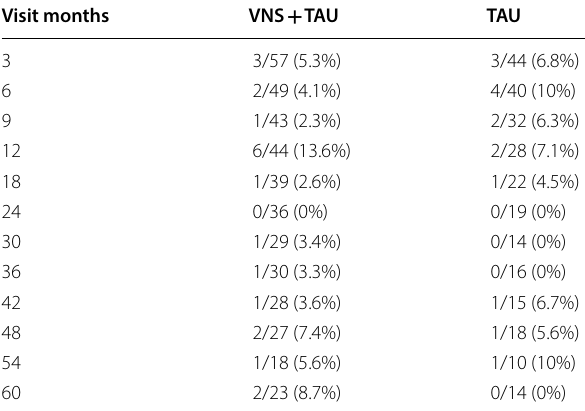
Table 5 Change in suicidal rating from non-severe to severe based on MADRS Item